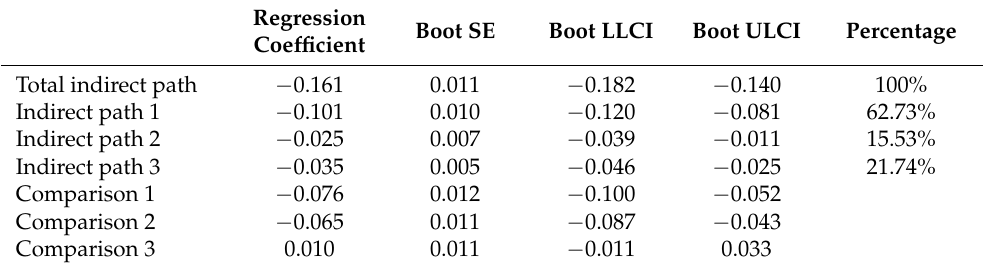
Table 3. Mediating paths comparison.